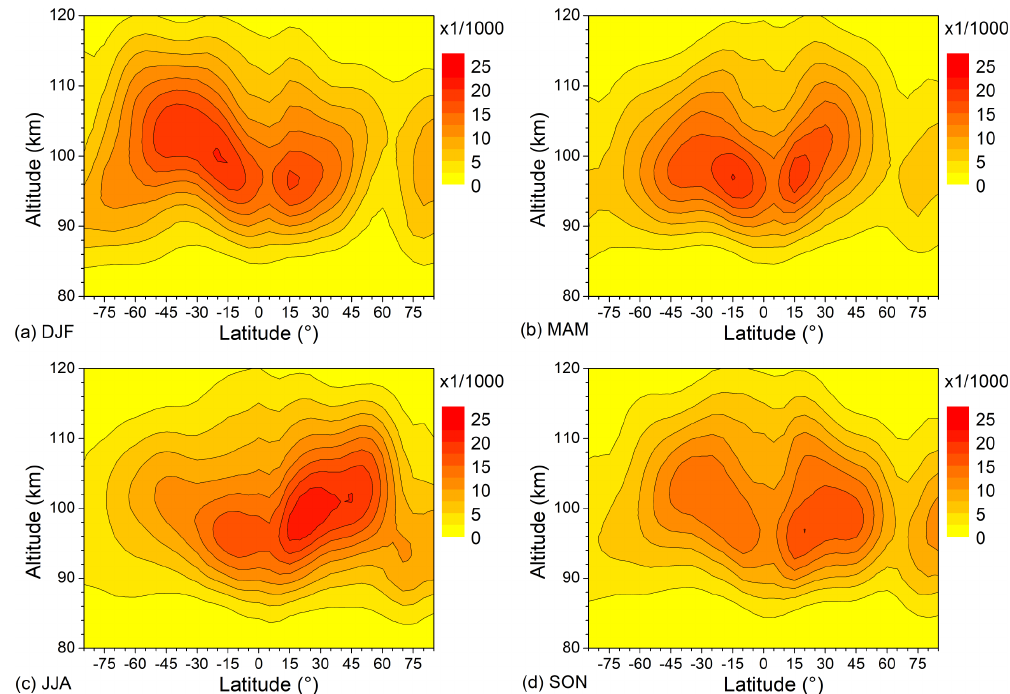
Figure 1. Zonal and seasonal mean Es occurrence rates for (a) DJF, (b) MAM, (c) JJA, and (d) SON. Data are averages over 2007–2016.